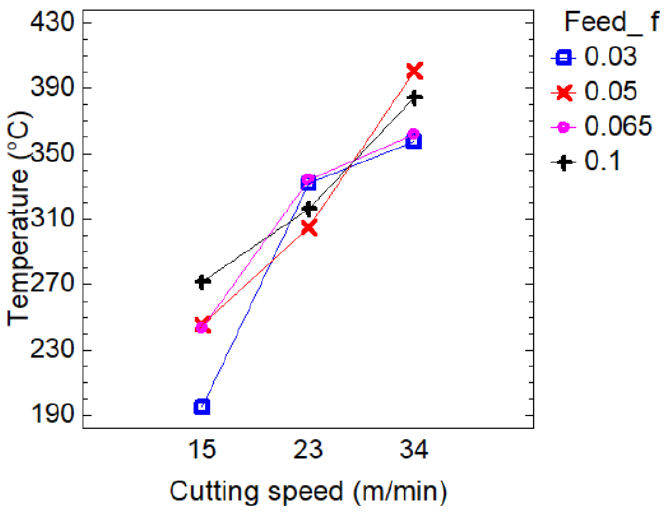
Figure 8. Interaction plot of the combined influence of cutting speed and feed on the cutting temperature.